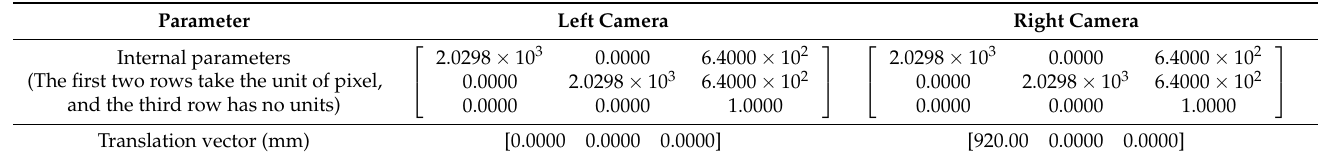
Table 1. Parameters of the simulated binocular